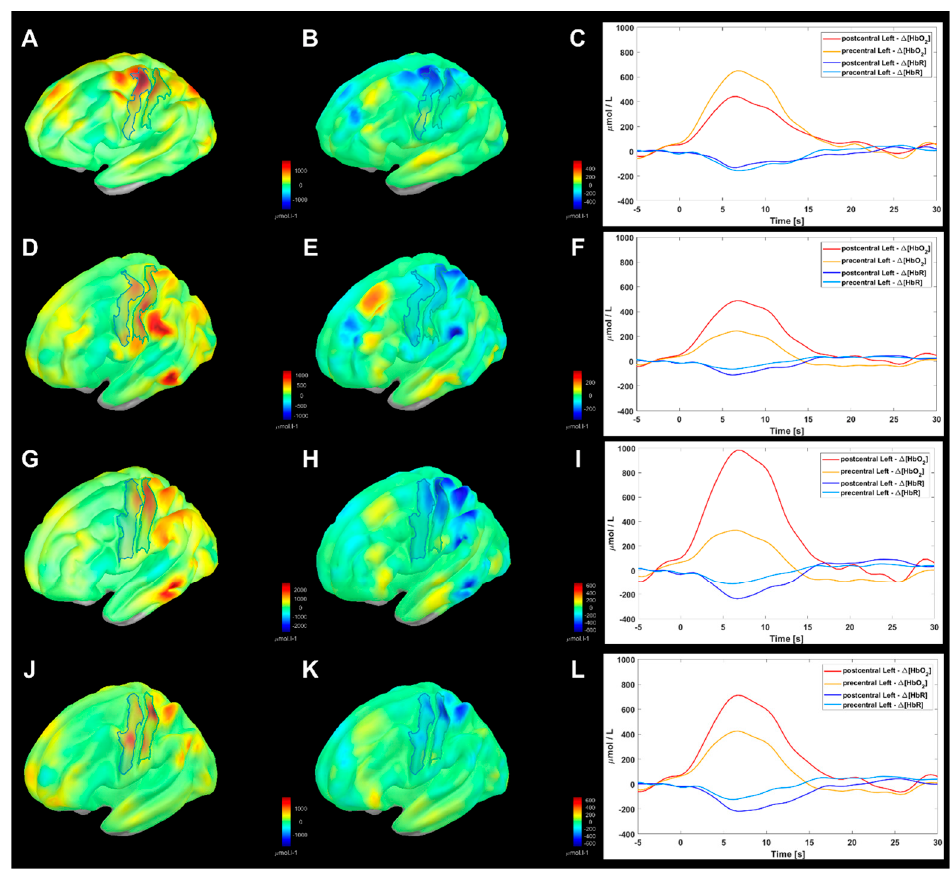
Figure 6. Example of block-averaged image reconstruction in a representative subject (i.e., subject #9) associated to right-hand grasping. From top to bottom: SSA case ( A – C ); Colin27 atlas ( D – F ); ICBM152 atlas ( G – I ); FSAverage atlas ( J – L ). From left to right: image reconstruction of ∆ [ HbO 2 ] μmol/L concentrations at peak response ( A , D , G , J ); image reconstruction of Δ[HbR] μmol/